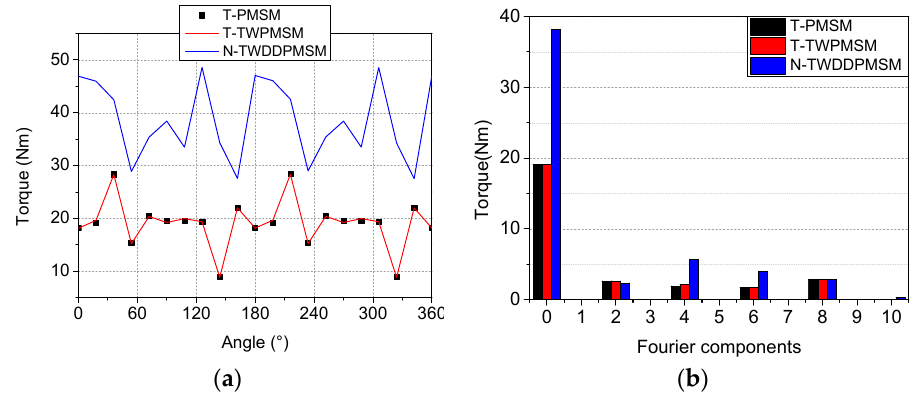
Figure 14. Waveforms of torques of three motors under rated operation: ( a ) torque waveforms; ( b )